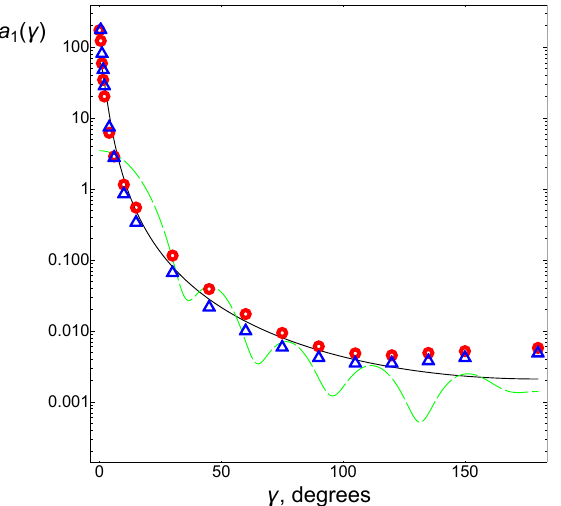
Figure 2. Examples of the angular dependence of the scattering phase function a 1 ( γ ) for sea water. The results obtained with Kopelevich’s model [47,48] and analytical parametrization (18) ( α = 2.7, g = 0.96 [15]) are depicted by symbols ( ○ , ⟨ cos γ ⟩ = 0.89, ∆ , ⟨ cos γ ⟩ = 0.92) and solid line, respectively. For comparison, the results of calculations with code [60] for aqueous suspension of polystyrene spheres (diameter d = 0.993 µ m, wavelength λ = 633 nm) are shown by dashed